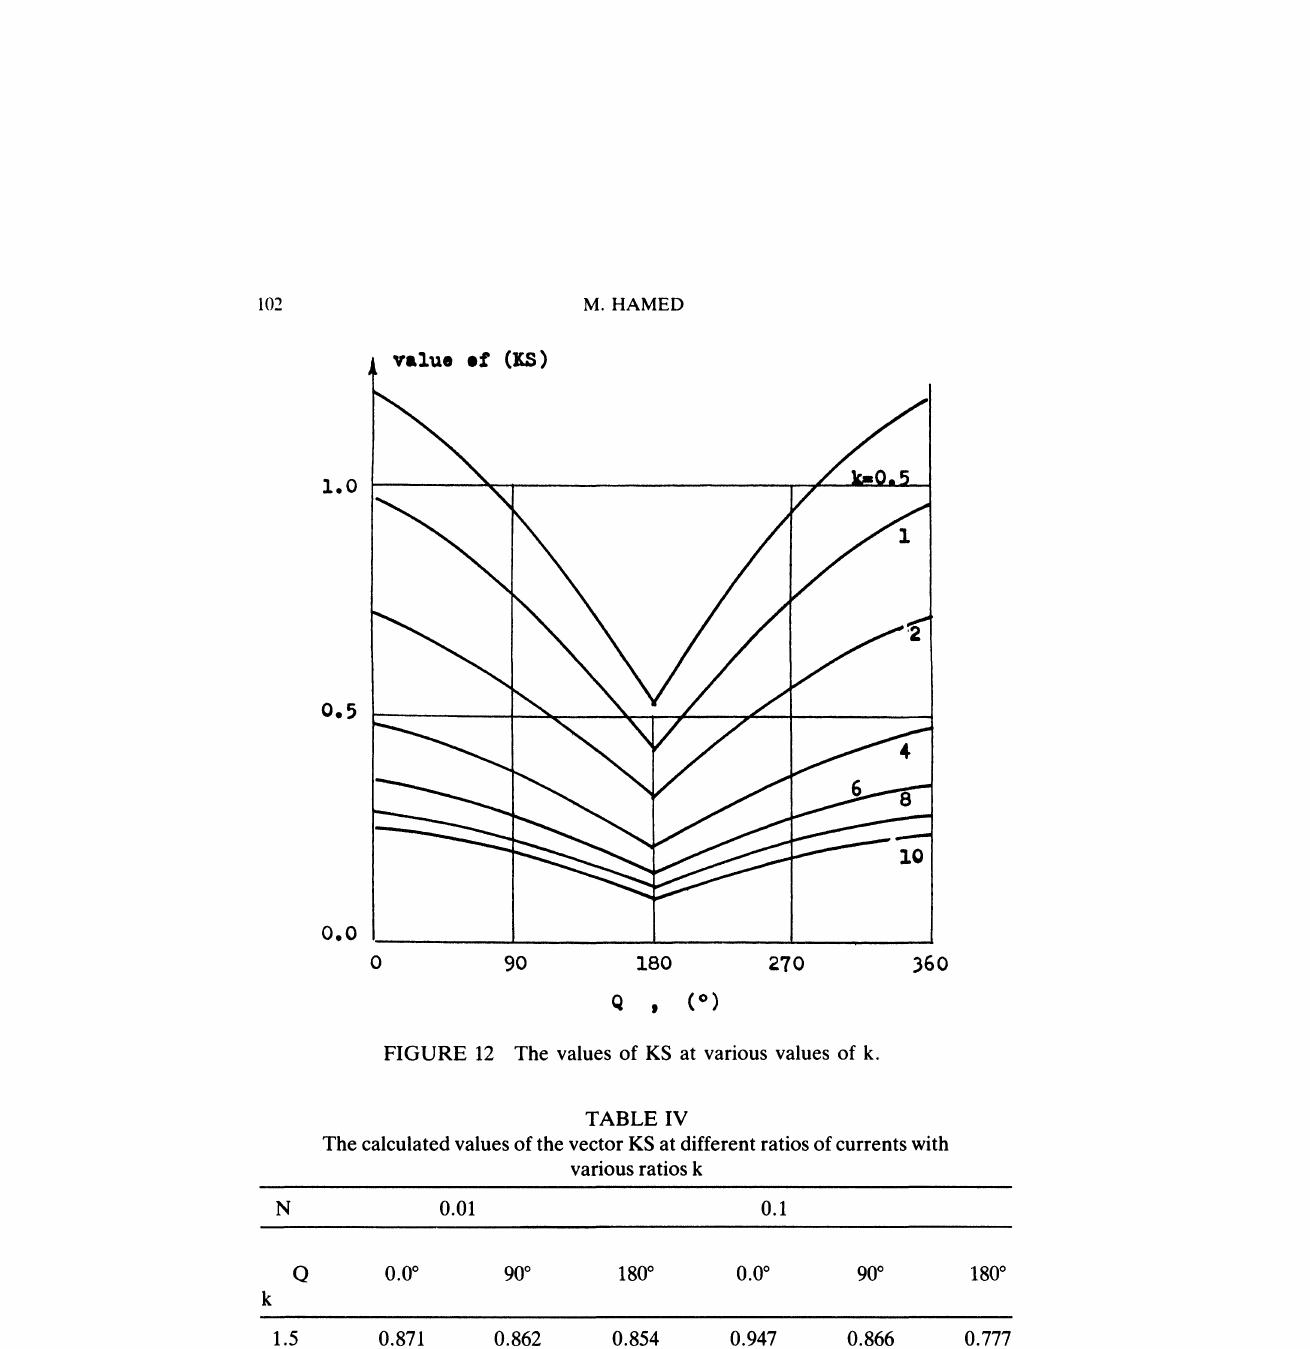
The calculated values of the vector KS at different ratios of currents with various ratios